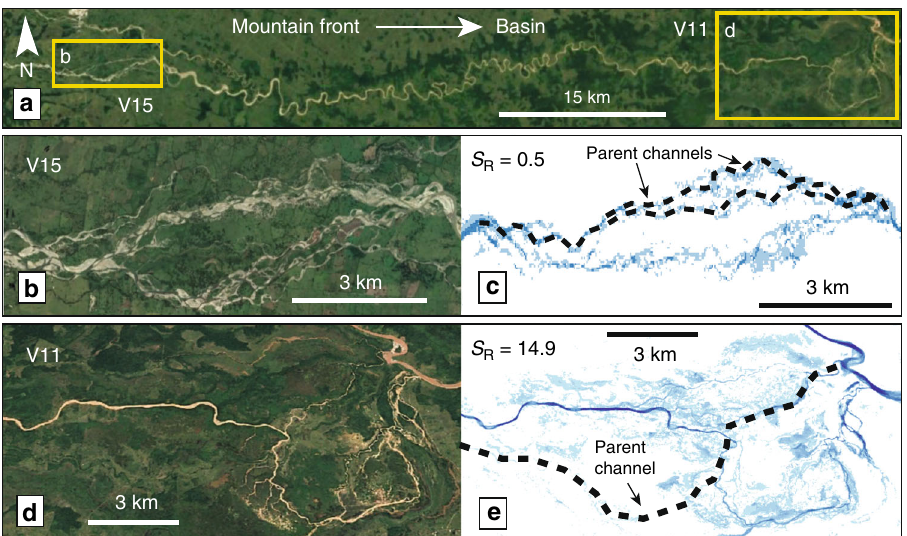
Fig. 5 Two avulsions on the Sarare River, Venezuela with different styles. a Avulsion sample V15 occurs close to the Andean range front, exhibits a braided, multithread channel morphology ( b ), and has a compact fi ngerprint ( c ). Avulsion V11 occurs in a more distal location, exhibits a meandering, single- thread channel morphology ( d ), and has a larger fi ngerprint ( e ). Black dashed lines in c and e mark the parent channel location prior to avulsion. In all maps fl ow is to the right. Satellite imagery from Google Earth Pro